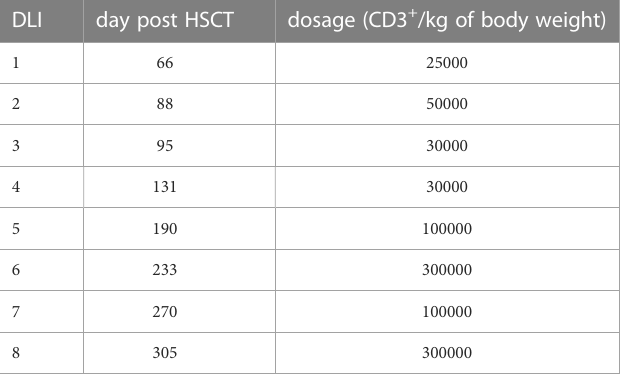
TABLE 1 DLI characteristics: dates and dosages of administered CD3 + cells are shown. DLI day post HSCT dosage (CD3 + /kg of body